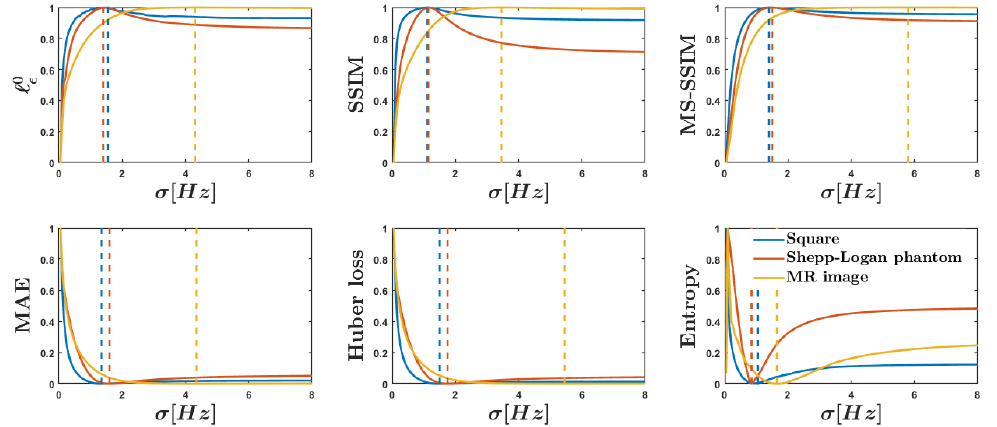
Figure 3. Evaluation of different Gaussian filters using (cid:96) 0 (cid:101) , SSIM, MS-SSIM, MAE, Huber loss and entropy. In all sections of the figure, we plot the results for the ideal square test image (blue), the Shepp–Logan phantom (red) and an MR head section (yellow). The dotted vertical lines of the same colour indicate a peak/nadir of the three metrics.